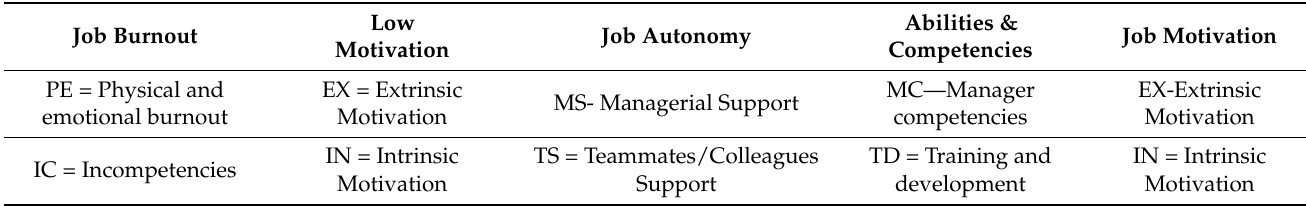
Table 4. Acronym of themes and